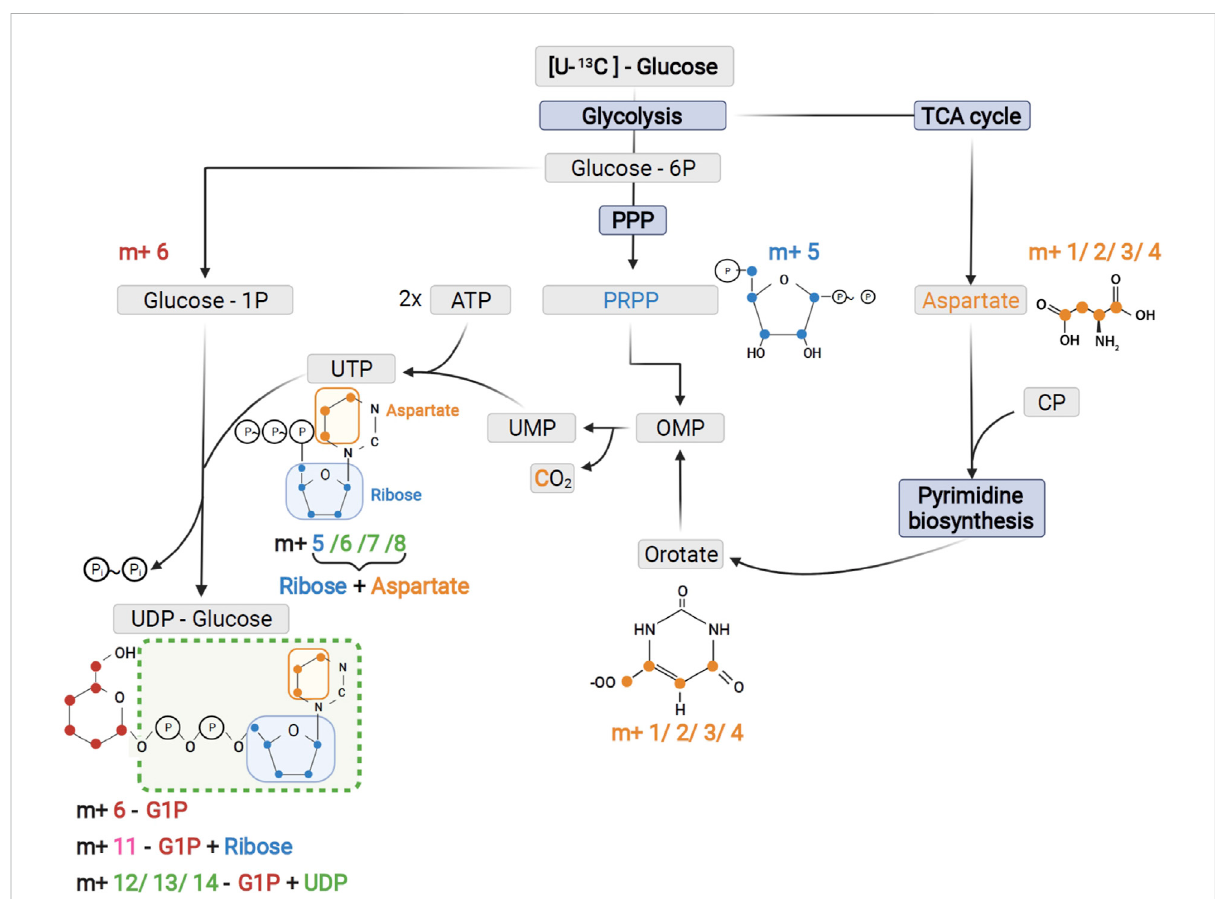
FIGURE 5 Schematic of UTP and UDP-Glucose biosynthesis with contribution of the different precursors to tracer incorporation from 13 C 6